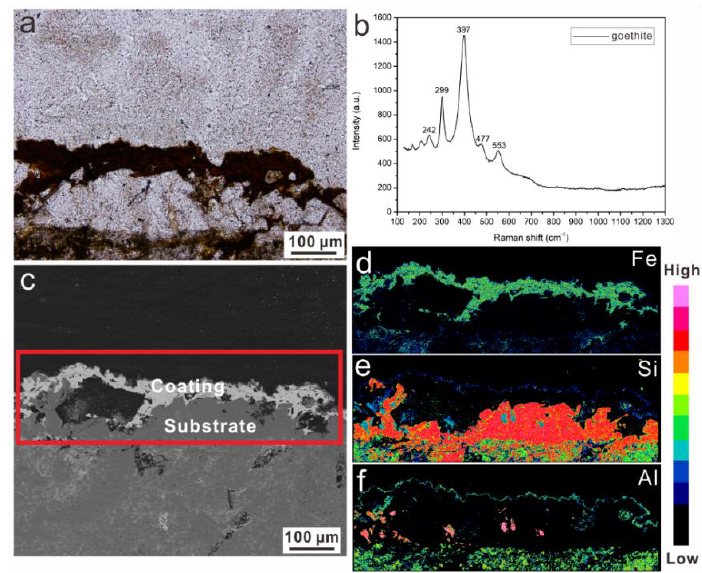
Figure 7. Optical image ( a ), Raman spectrum ( b ), back-scattered image ( c ) and elemental distribution patterns ( d – f ) of the rock Fe coating. The rectangle in panel ( c ) indicates the EDS mapping region.